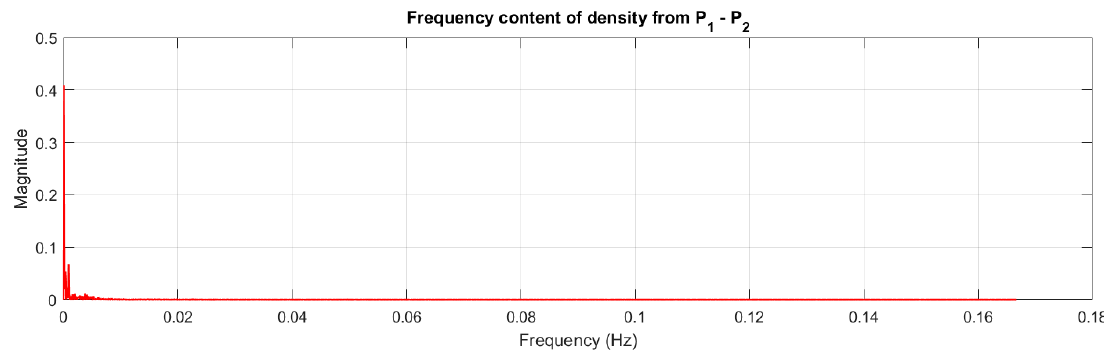
Figure 8. Frequency analysis of the density measurements using FFT.